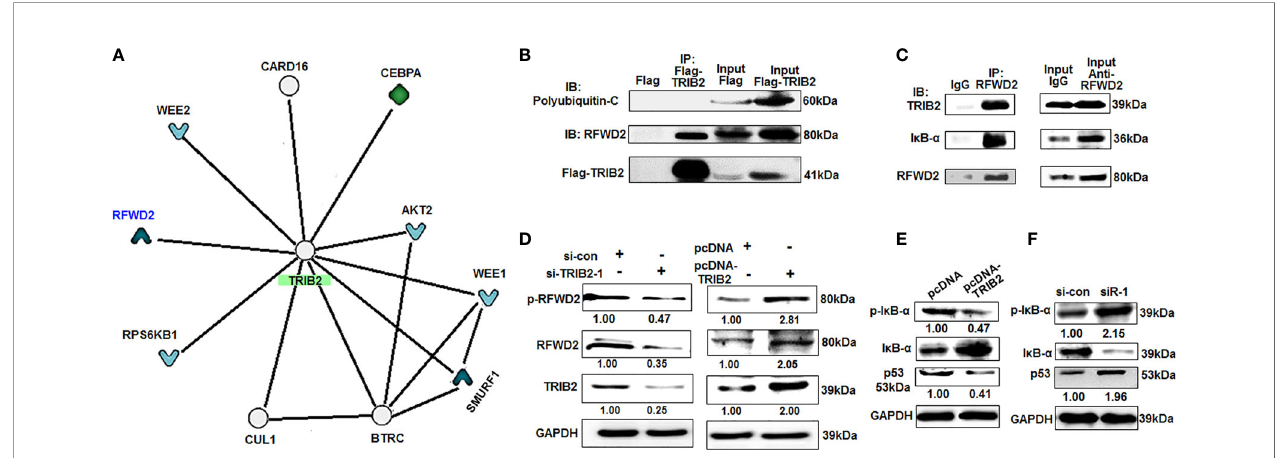
FIGURE 2 | TRIB2 interacts with RFWD2. (A) The results of inBio Discover ™ showed that TRIB2 may interact with RFWD2, CEBPA, WEE2, etc. (B) 293T cells were transiently transfected with Flag-TRIB2 or Flag vector for 48 h, and then the total lysate was coimmunoprecipitated using M2 af fi nity gel. (C) Whole-cell lysate of 293T cells was immunoprecipited with RFWD2 antibody followed by immunoblotting with antibodies against indicated proteins. (D) TRIB2 positively regulates the expression of RFWD2 and si-TRIB2 inhibits p-RFWD2 and RFWD2 levels, as shown by Western blotting analysis. Expression levels of RFWD2 and TRIB2 quanti fi ed via ImageJ software and normalized to GAPDH. (E, F) Expression levels of I k B- a , p-I k B- a , and p53 in A549 cells treated with pcDNA-TRIB2 or TRIB2-siRNA and controls assessed by Western blotting. GAPDH was used as the loading